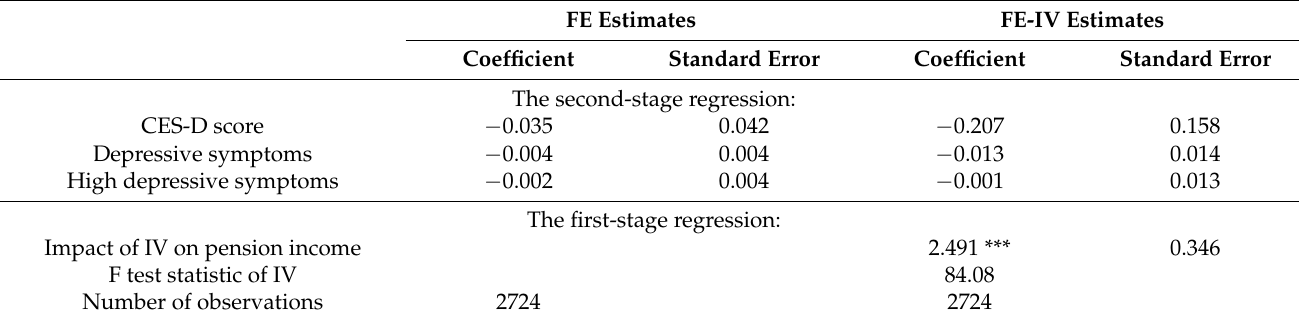
Table 4. Impact of the NRSPI pensions on mental health